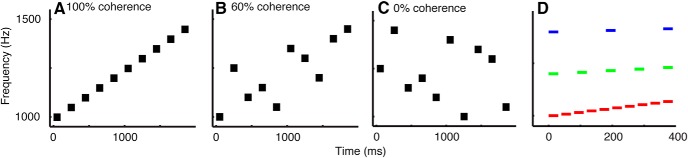
Example auditory sequences characterized in terms of coherence and different interburst intervals. A, Frequency direction (i.e., increasing) is easiest to discriminate when the stimulus is 100% coherent. As coherence gets smaller (60% in B and 0% in C), frequency direction becomes more ambiguous and, thus, can lead to more errors. In A−C, we show increasing auditory sequences. Decreasing sequences are analogous but with negative coherence values. D shows a 100% coherence auditory sequence at three different IBIs: 10 ms (red), 60 ms (green), and 150 ms (blue).